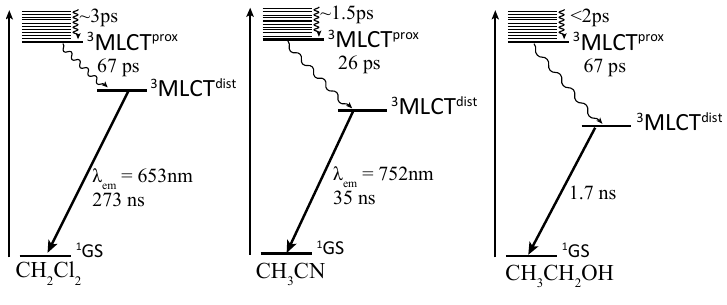
Figure 11. Jablonski diagrams of [Ru(bpy) CH OH (right). MLCT dist stands for the distal portion of DPPZ while MLCT prox and CH 3 2 stands for the proximal portion of DPPZ